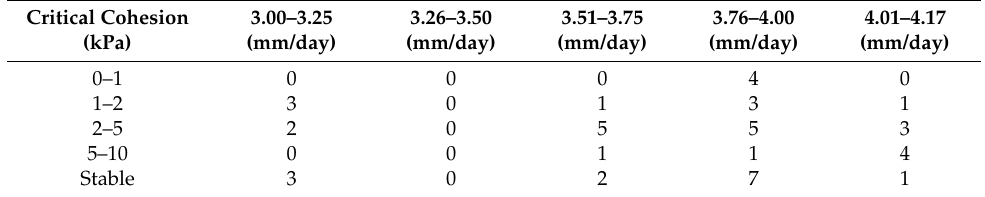
Figure 6. Slope map of the Paraty municipality. Table 4. Correlation matrix for landslide frequency in terms of critical cohesion and average